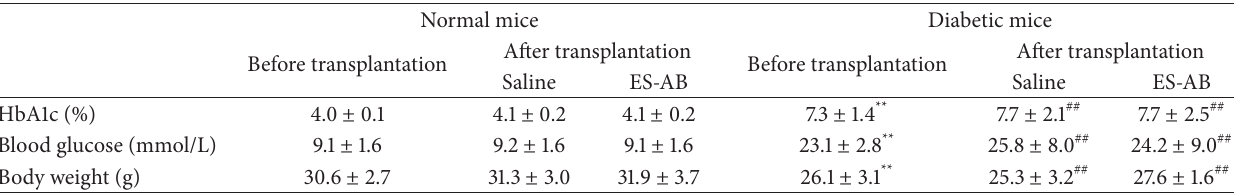
Table 2: Body weight, blood glucose, and HbA1c levels. Normal mice Diabetic mice After transplantation After transplantation Before transplantation Before transplantation Saline ES-AB Saline